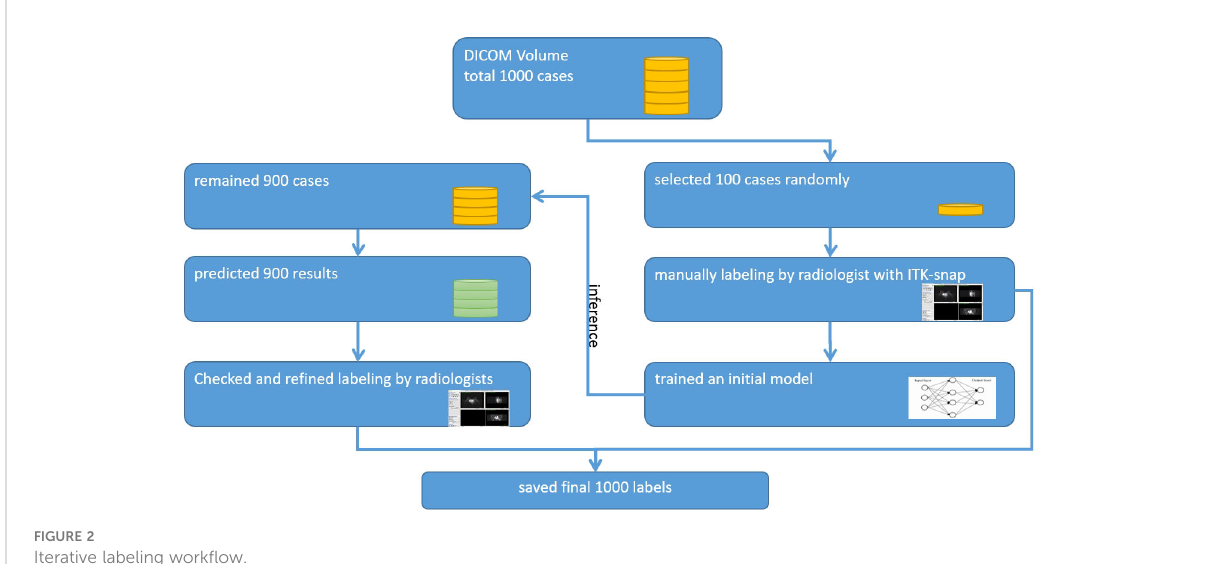
FIGURE 2 Iterative labeling work fl